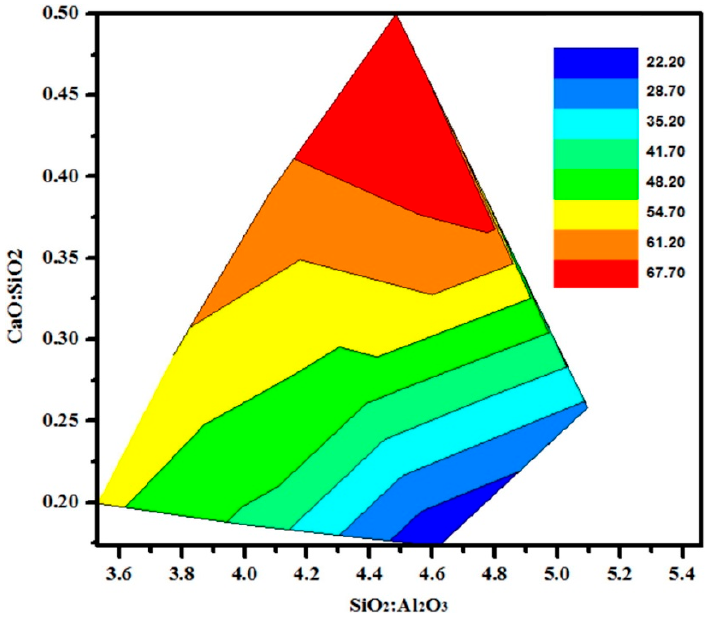
Figure 1. Effect of varying Ca:Si on the compressive strength of WCP-based geopolymer. Reig et al. [87] have investigated the application of ceramic tile waste (TCW) as both a precursor (TCWP) and a recycled aggregate (TCWA) to attain a binding mix through